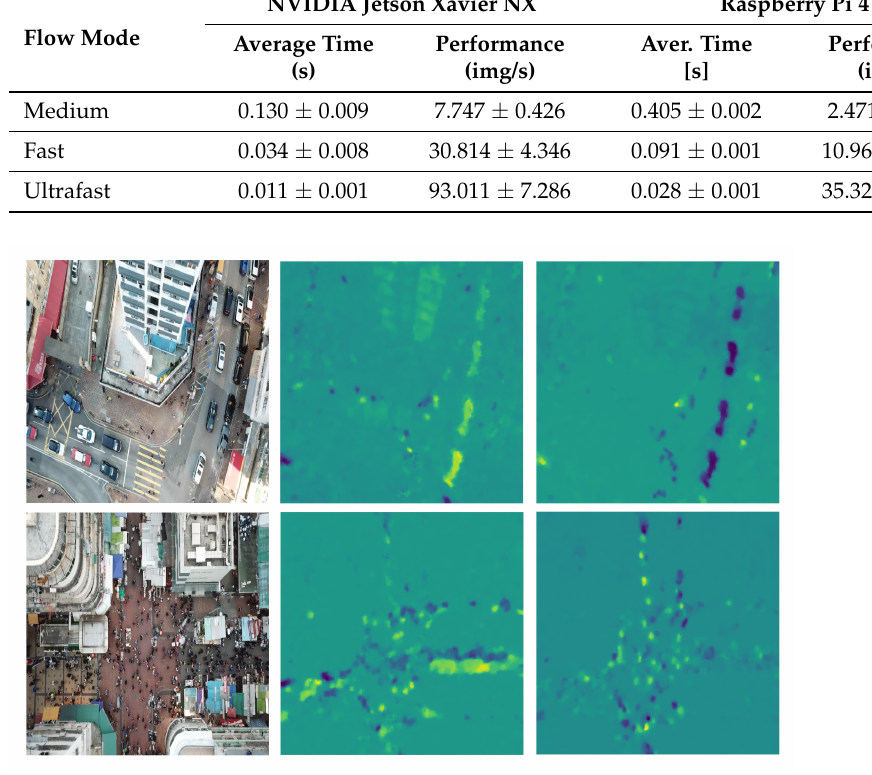
Figure 3. Example frames of using DIS optical flow algorithm. The left column presents the original input images. The middle column represents the x -axis component, whereas the y-axis component of flow is illustrated on the right